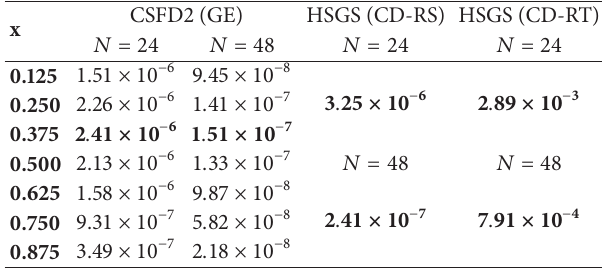
Table 1: Comparison between CSFD2 (GE), HSGS (CD-RT), and HSGS (CD-RS) for Example 1.